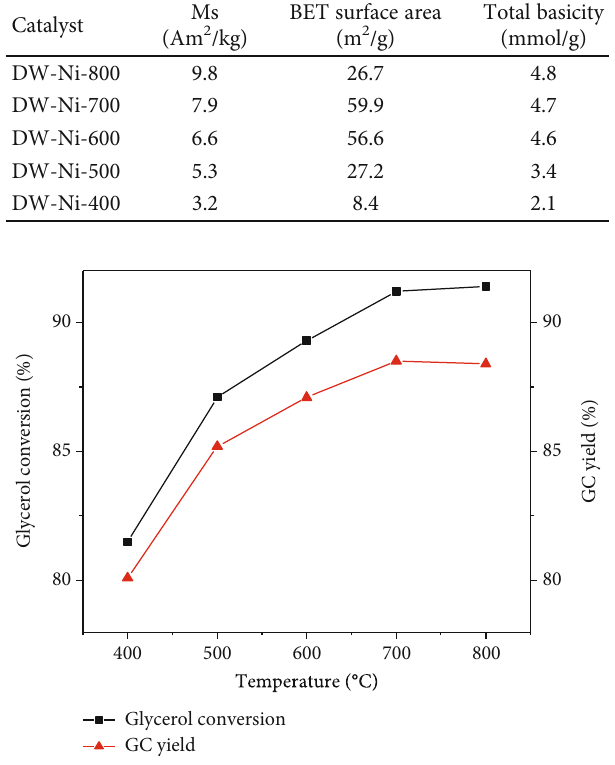
Figure 5: The catalytic activity of the DW-Ni catalysts.